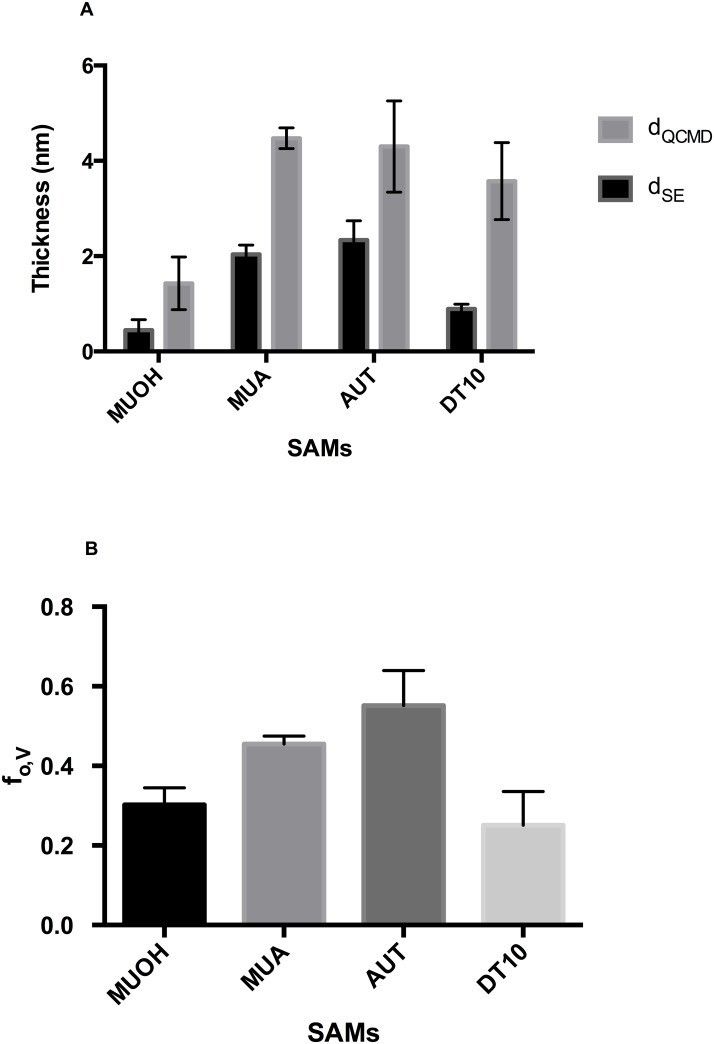
Averages from triplicate SE/QCM-D measurements.(A) SE and QCM-D thickness parameters (dSE, dQCMD, respectively) of different SAM surfaces with associated standard errors. (B) Adsorbate volume fractions (fo,V) of different SAM surfaces with associated standard errors.